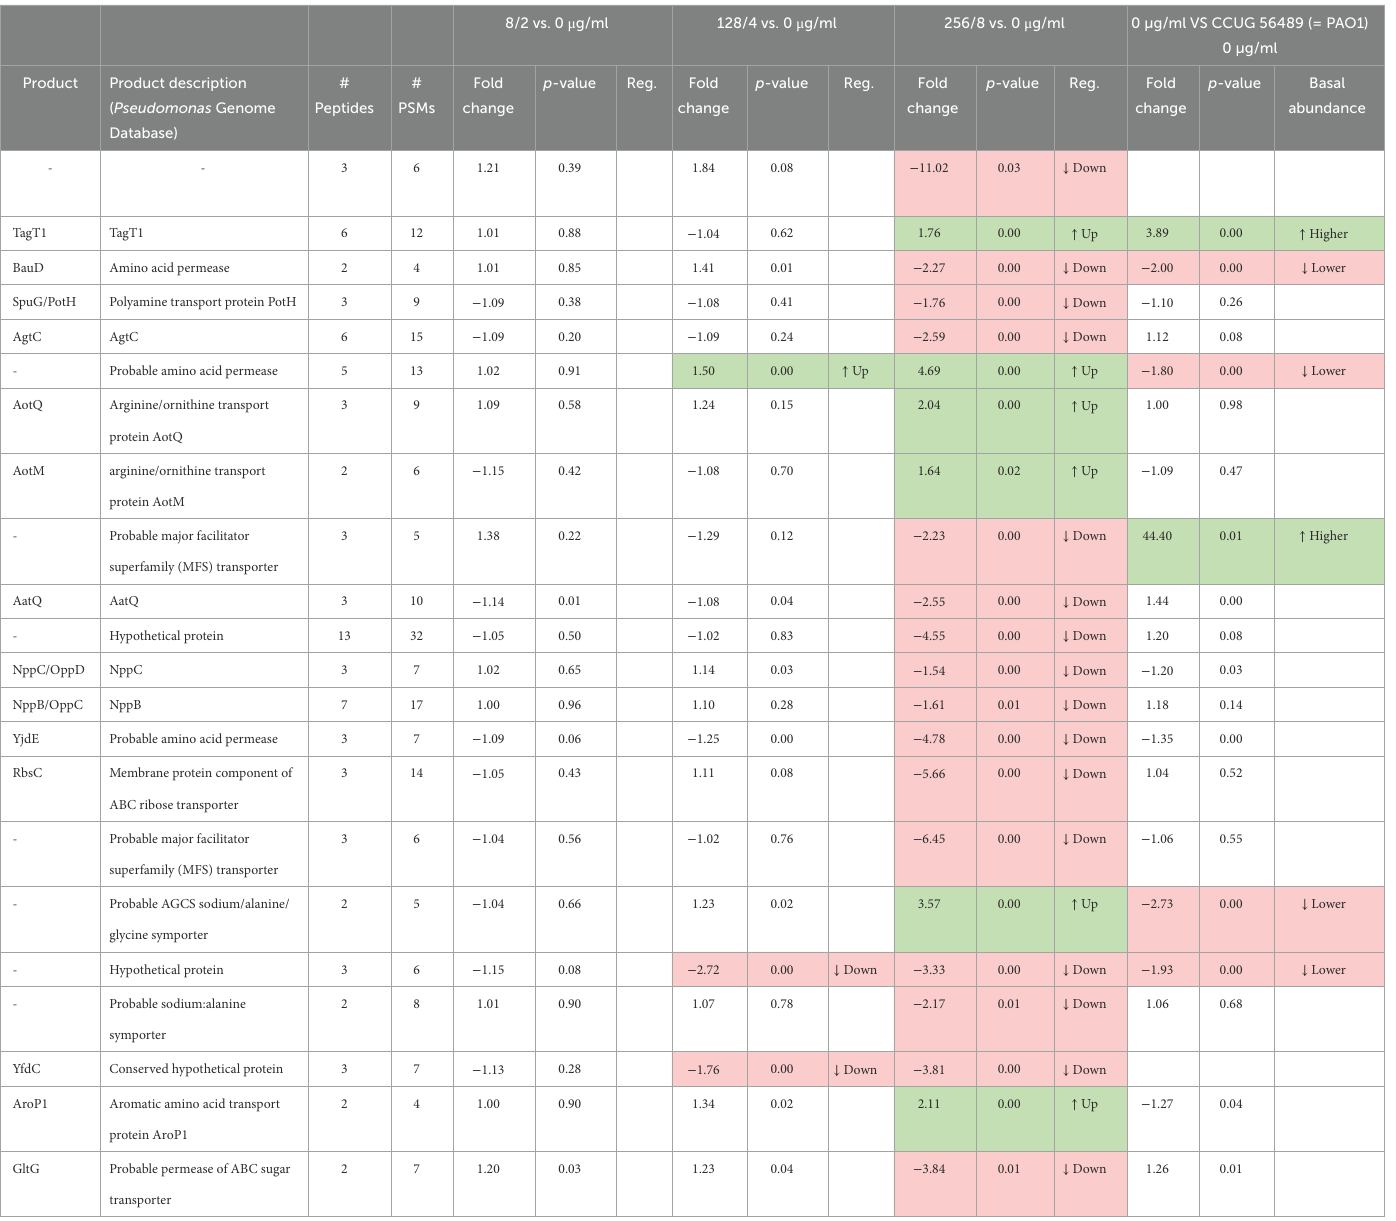
TABLE 5 Additional differentially regulated proteins related with transmembrane